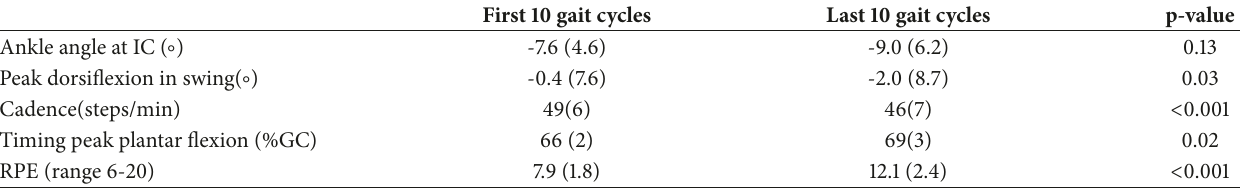
Table 2: Means (SD) of the gait characteristics and RPE in the first and last 10 gait cycles of the 6minWT.